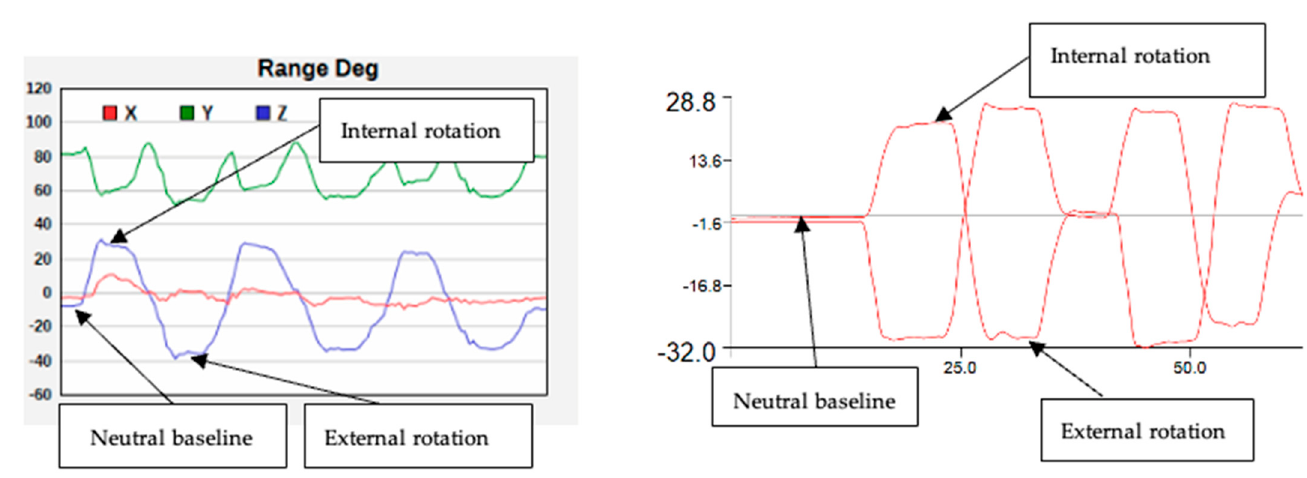
Figure 2. Estimating hip range using the smartphone ( left ) and the 3D motion capture ( right ). To calculate the maximum hip range the neutral baseline angle was subtracted from the maximum internal or external rotation values.